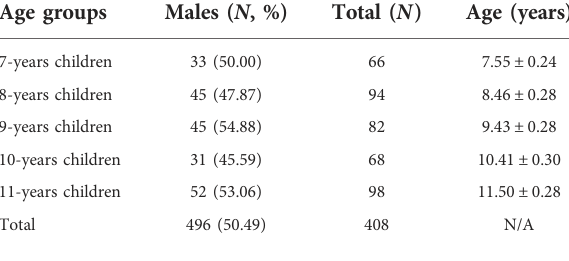
TABLE 1 Demographic characteristics of